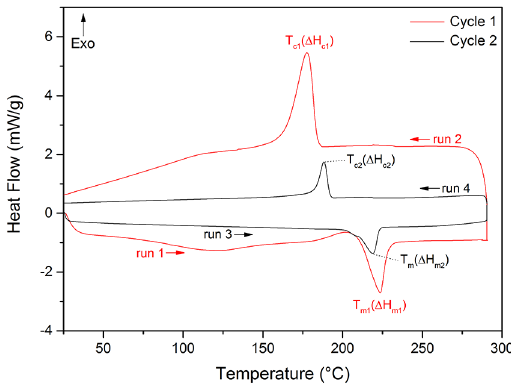
Figure 1. PA matrix DSC thermal analysis. (Bibliographic Source: Author.)